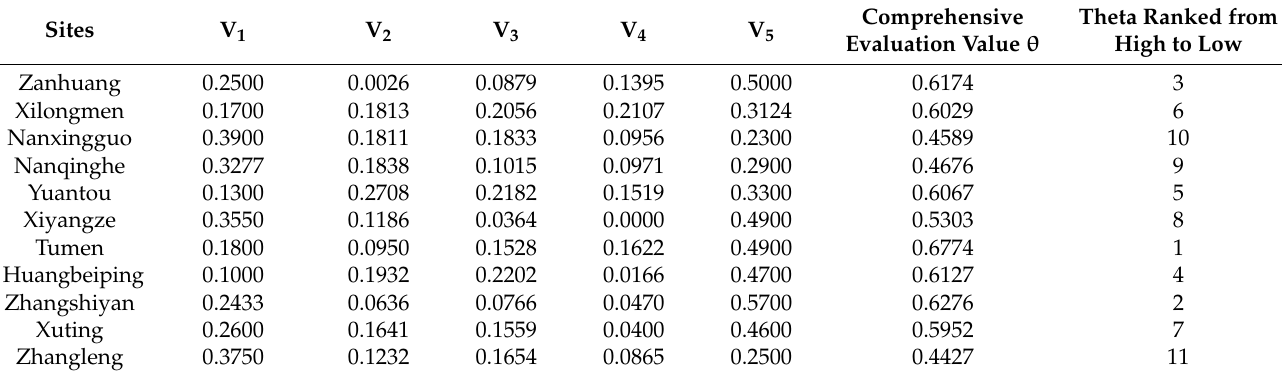
Table 3. Comprehensive evaluation results of water resources carrying capacity by the analytic hierarchy process in Zanhuang County.